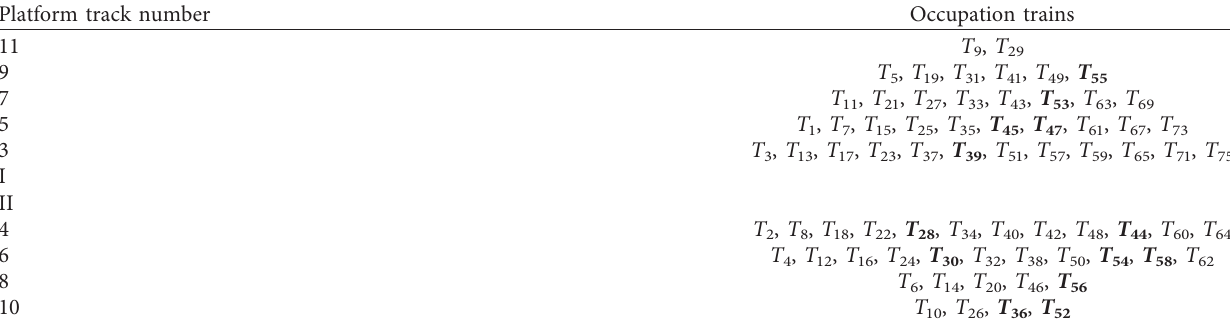
Table 11: Platform tack assignment plan after the reoptimization using CPLEX-WV for the scenario (70, 10, 0). Platform track